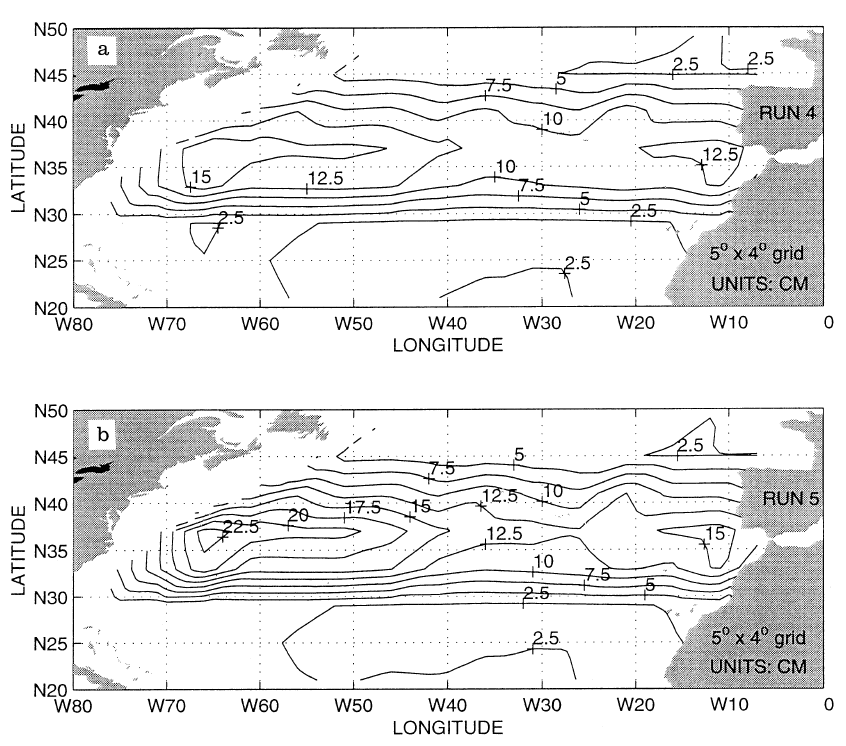
Fig. 9a,b. Uncertainty (cm) in the mean dynamic topography estimated by the inverse model when error bars in the density field are multiplied by 10 in the 30 (cid:176) N–40 (cid:176) N latitude band. a With altimetric constraints (run 4); b without altimetric constraints